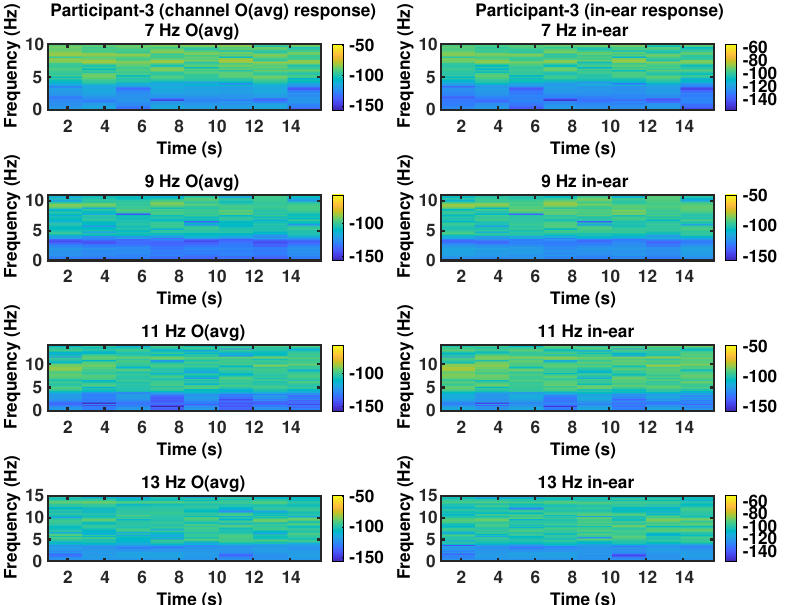
Figure 9. Spectrogram of participant 3 from occipital and in-ear